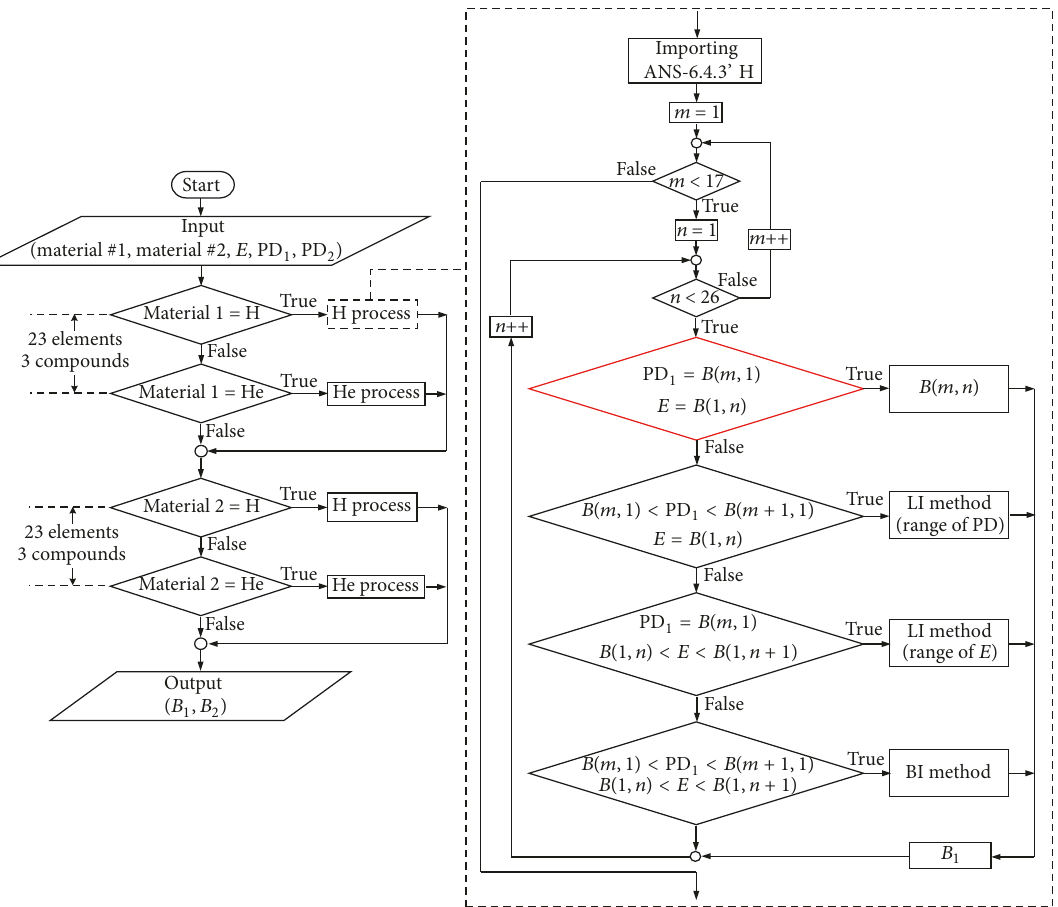
Figure 7: Flowchart of exposure buildup factor (𝐵)